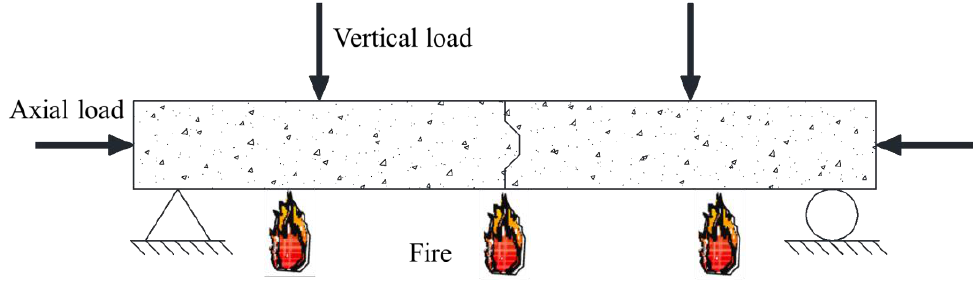
Figure 4. Loading methods.